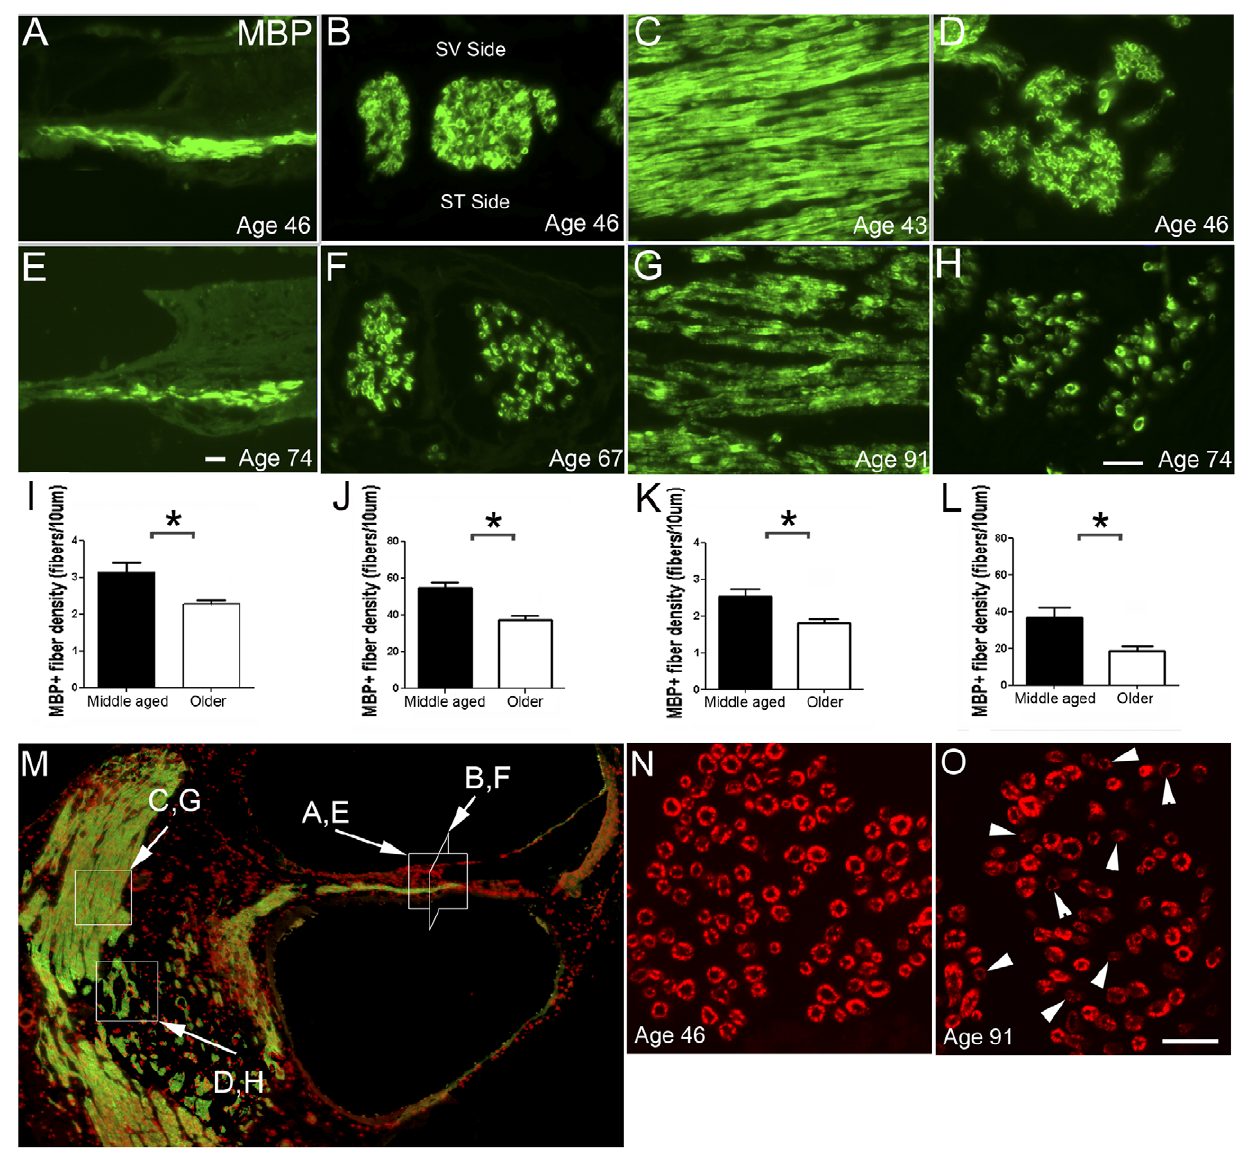
Figure 9. Age-related reduction of MBP + fibers and immunostaining for MBP in human ears. A–L; N–O: A significant loss of MBP + fibers occurred with age in both the peripheral and central portions of the auditory nerve. MBP + nerve fibers are illustrated in peripheral ( A, B ) and central ( C, D ) portions of the auditory nerve in the ears taken from middle-aged ( A–D ) and old ( E–H ) donors. White boxes with associated letters in M illustrated the regions of the cochlea depicted in A–H . Counts of MBP + fibers in both peripheral ( I, J ) and central ( K, L ) projections revealed a statistically significant reduction in fiber density in older compared to middle aged human cochleas using an unpaired t-test ( * p , 0.05). N, O: A reduction in the intensity of MBP immunoreactivity was seen in many myelinated fibers of a 91-year-old donor (white arrowheads). Scala vestibuli, SV; Scala tympani, ST. Scale bar, 10 m m in E (applies to A, E ); 12 m m in H (applies to B–D ; F–H ); 12 m m in O (applies to N, O ).